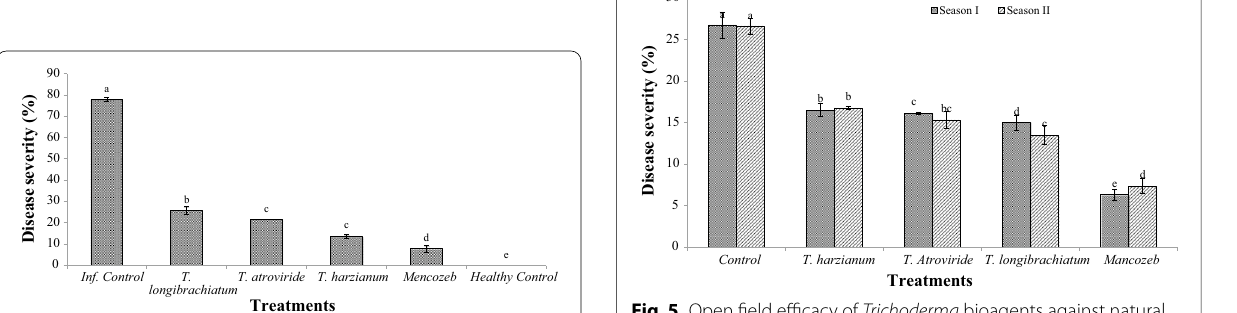
Fig. 4 Efficacy of bioagents on disease severity (%) of artificially inoculated virulent isolate of Alternaria solani on tomato plants in greenhouse. Values followed by different letters indicate that means are significantly different from one another according to Fisher’s least significant difference at p 0.05. Error bars on graphs represents the = Mean SE ±